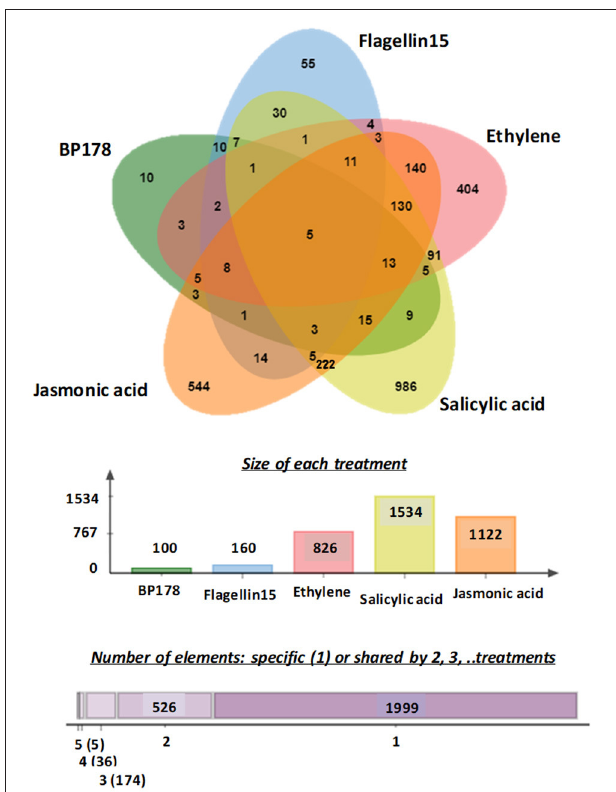
FIGURE 3 | A Venn diagram of overexpressed genes in tomato plants after BP178, flagelin15, ethylene, salicylic acid, and jasmonic acid treatment. Overlapping regions of the circles indicate genes that are overexpressed in more than one treatment. Genes with fold-change above two were included in the analysis. The numbers in the graphic indicate the total numbers of overexpressed genes in each treatment. In the second chart, 1,999 overexpressed genes are specific of one list; 526 overexpressed genes are shared by two lists. Numbers in brackets represent the number of overexpressed genes shared by three, four, and five